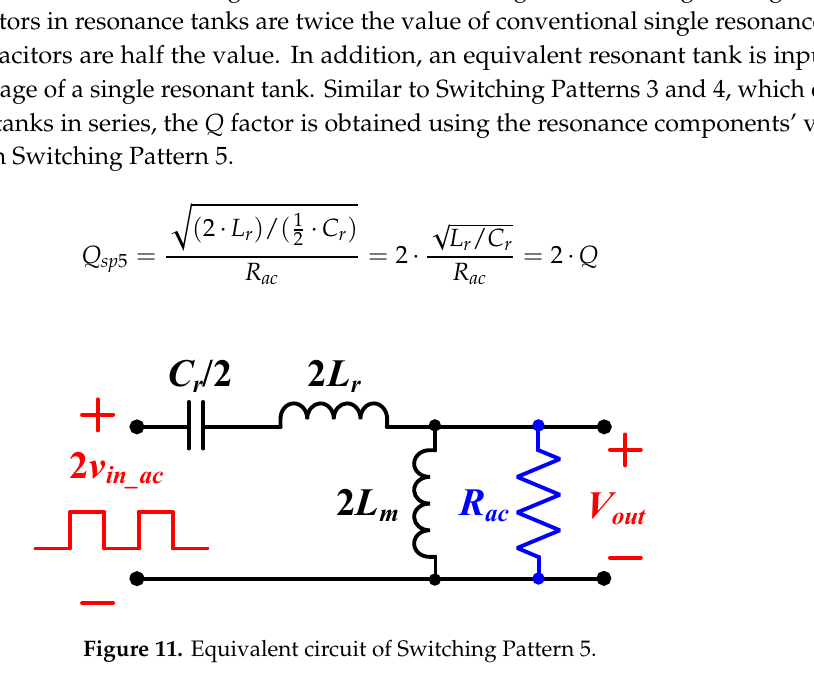
Figure 10. Current path of Switching Pattern 5.